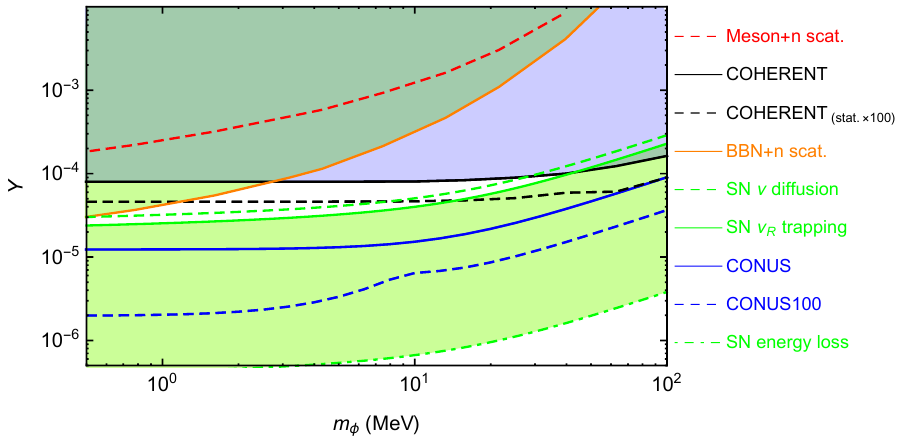
Figure 4 . Constraints from CE (cid:23)N S experiments on ( Y; m (cid:30) ) for a lepton number conserving interaction, see eq. (2.1). The black, dashed black, blue, and dashed blue curves correspond to the 95% C.L. constraint of the recent COHERENT data, the sensitivities of future COHERENT, CONUS 4 kg 1 year, and CONUS 100 kg 5 years (light-blue) respectively. Various other limits (cid:2) (cid:2) from particle and astroparticle physics are explained in section 3.